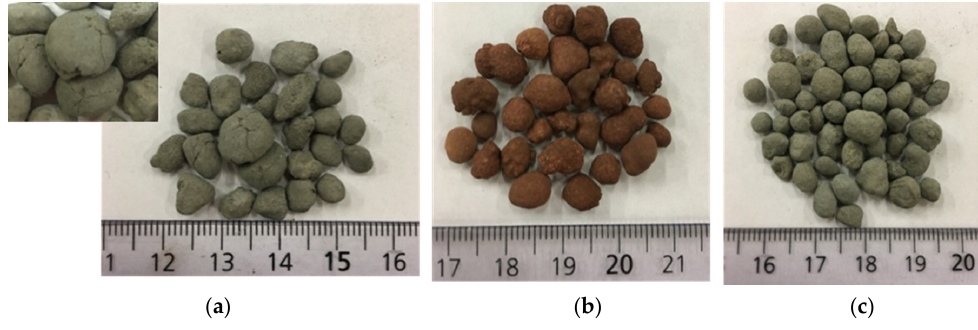
Figure 7. The appearance of ( a ) MSWI BA 6 M, ( b ) Lusi 6 M, ( c ) FA 6 M.